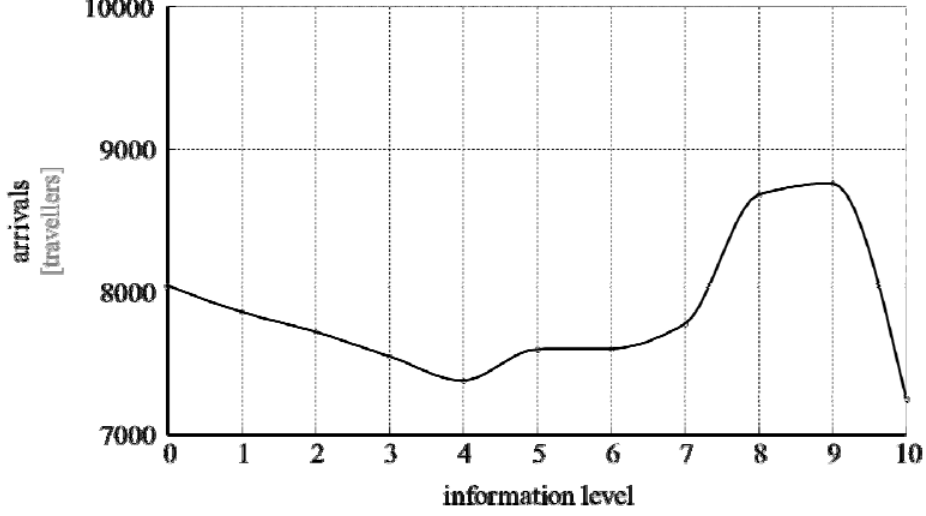
Figure 9. Number of arrivals as a function of traffic information levels